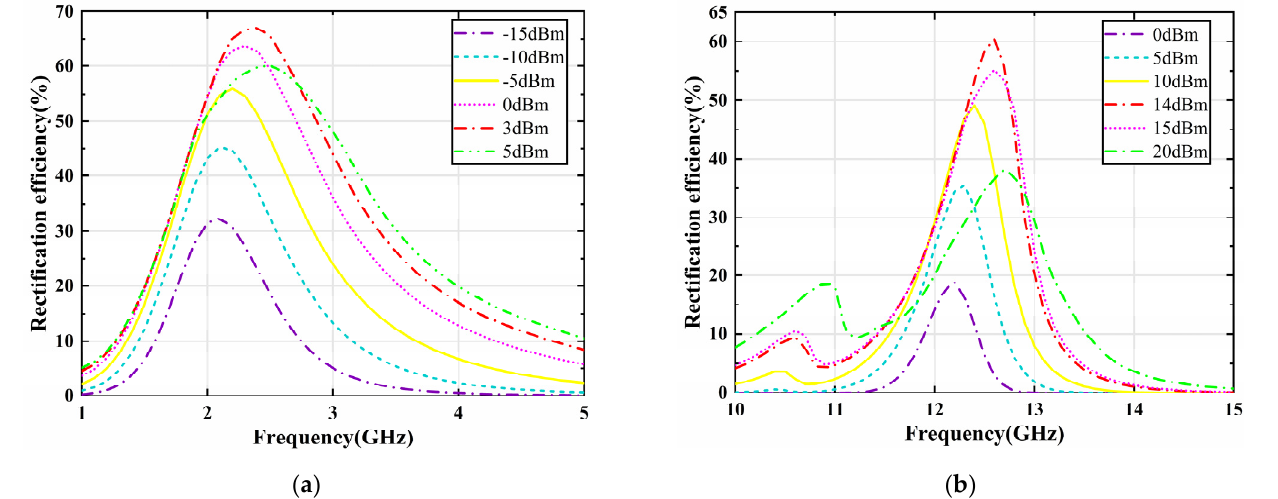
Figure 8. Simulated rectification efficiency curves versus frequency for ( a ) the single series diode rectifier and ( b ) the voltage doubler rectifier at different input power levels.